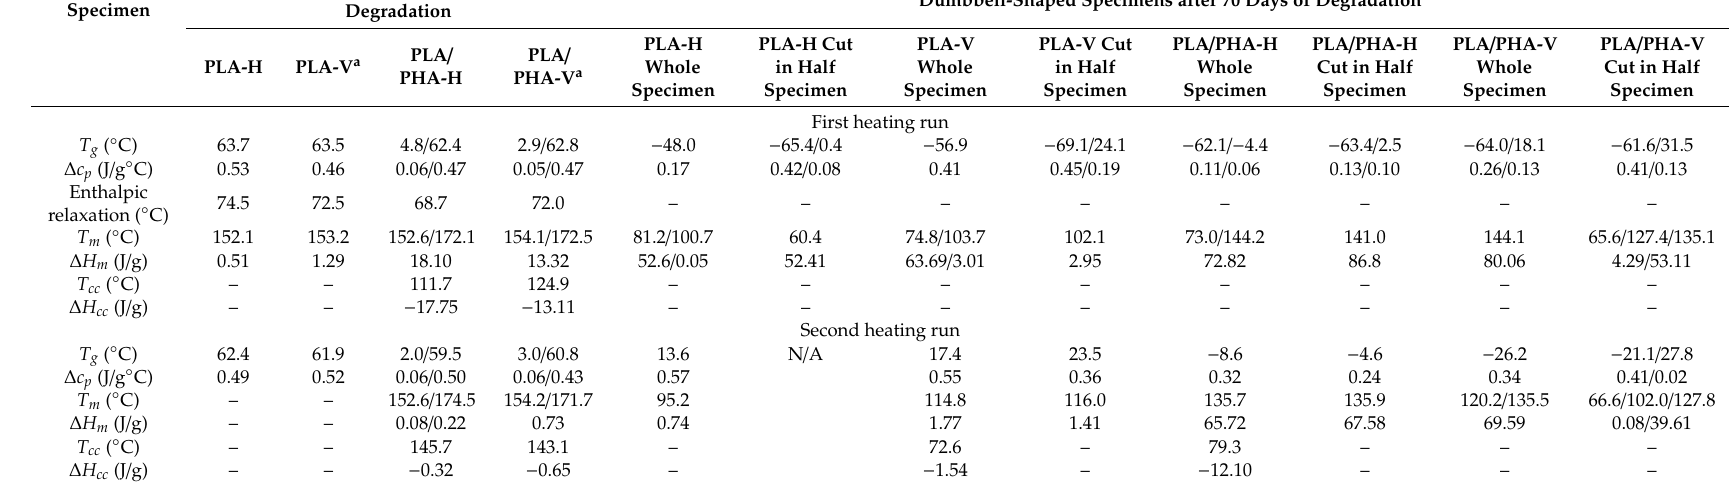
Table 2. Thermal properties before and after 70 days of hydrolytic degradation of PLA and PLA / PHA dumbbell-shaped specimens obtained by 3D printing in horizontal (H) and vertical (V) directions (heating rate: 20 ◦ C /